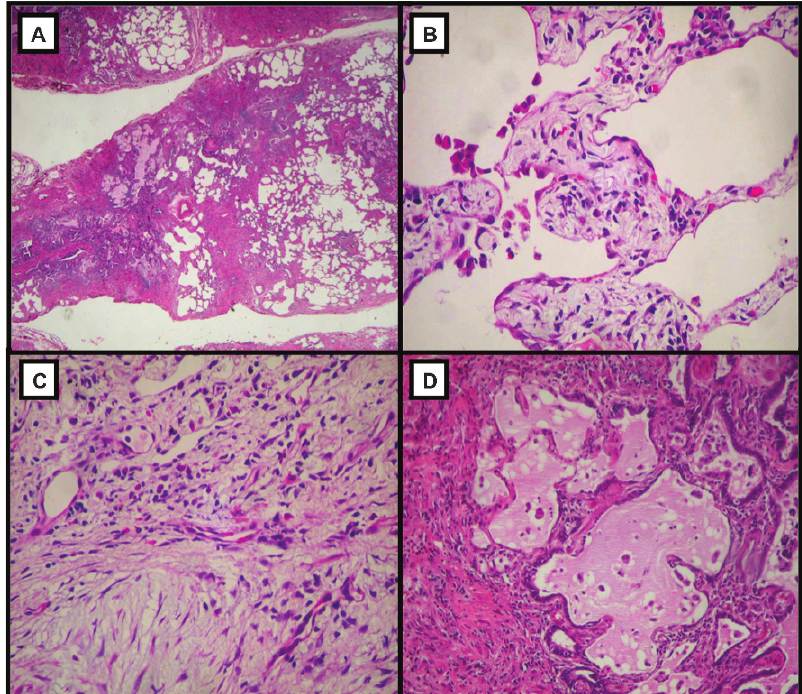
Figure 1 - Panoramic view showing unaffected areas alternating with fibrous and cystic changes, which characterize the UIP histological pattern (A, 6 40); collapsed area with alveolar collapse and interstitial mononuclear infiltrates (B, 6 100); mural fibrosis area with septal fibromyxoid tissue and fibroblastic foci (C, 6 100); and honeycombing area with irregular cystic air spaces between bands of fibrous connective tissue (D, 6 100). Hematoxylin and eosin